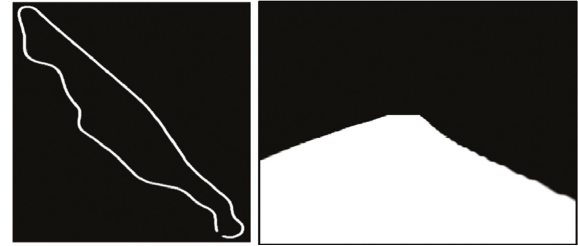
Figure 4: Simulator preview. The left image shows the global map of our simulator. The right image is a rendered image taken from the camera’s point of